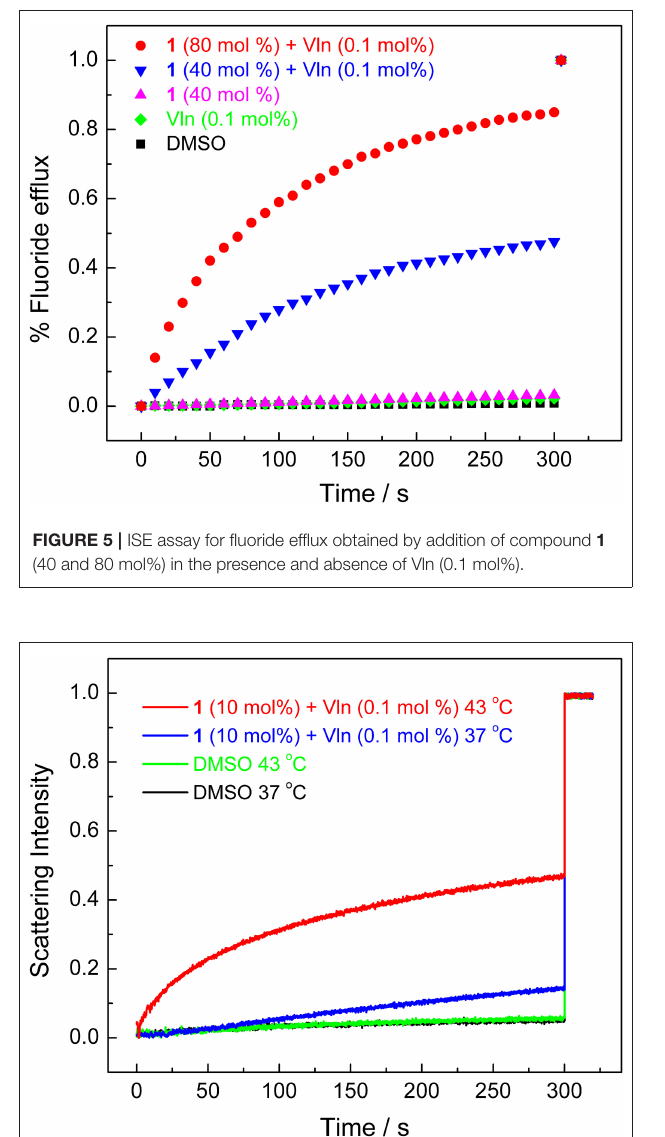
confirming the electrogenic anion transport mechanism. Again, acyclic compounds 2 – 3 show negative response in the ISE assay ( Supplementary Figure 26